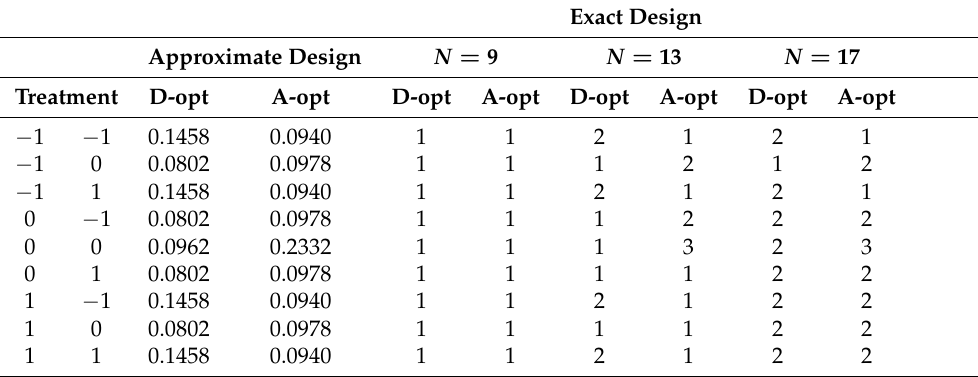
Table 2. D- and A-optimal designs for Model 1, where k = 9 and N = { 9,13,17 } .